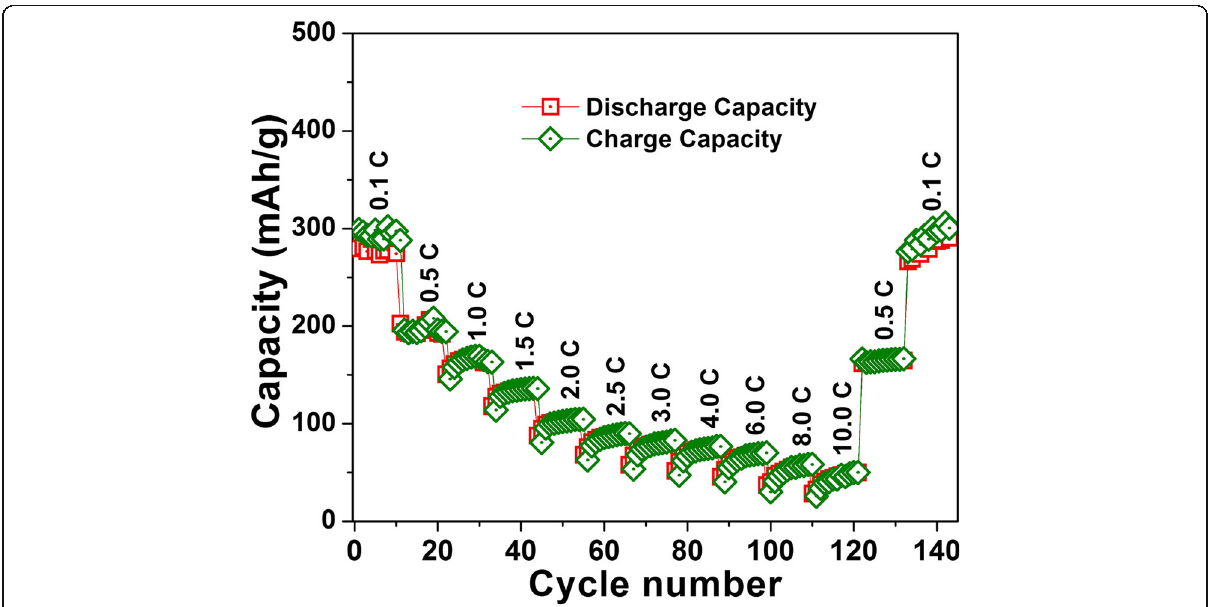
Fig. 6 Li-ion battery rate performance of a-VOx-6 Pa